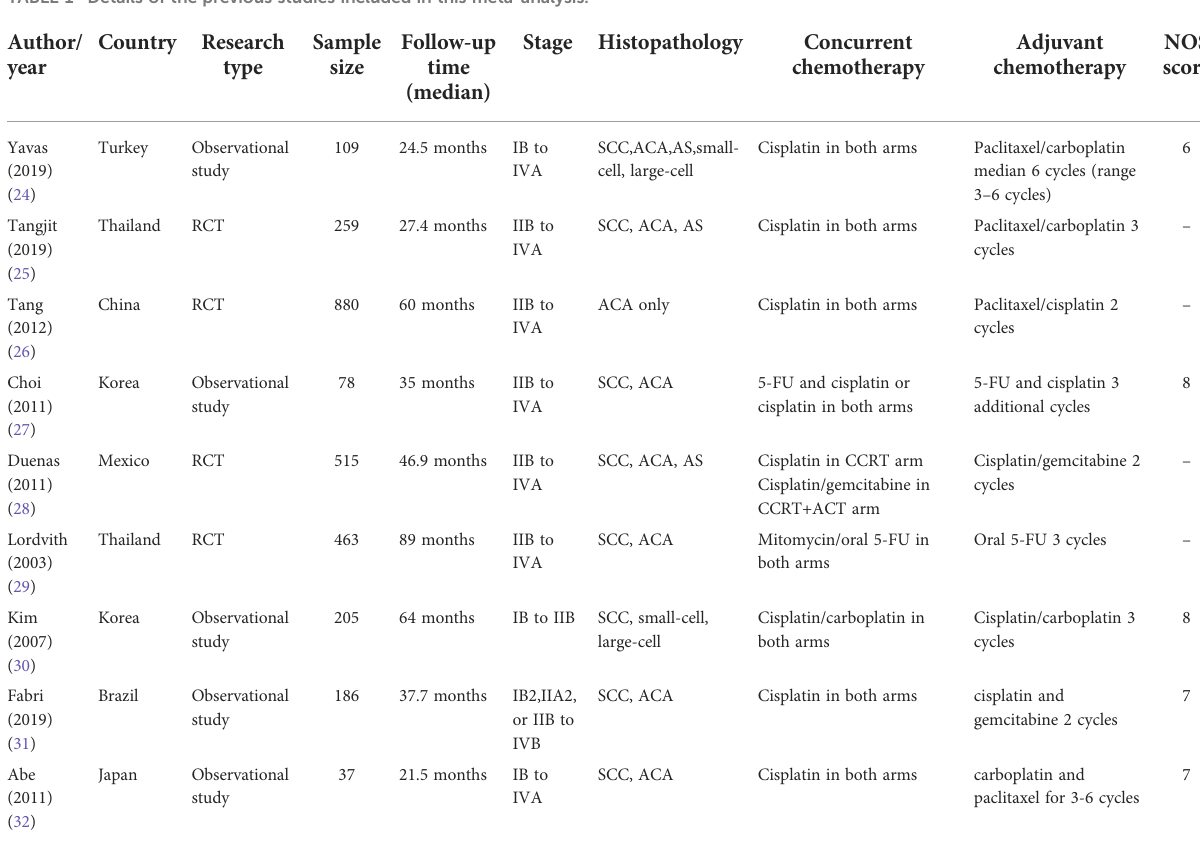
TABLE 1 Details of the previous studies included in this